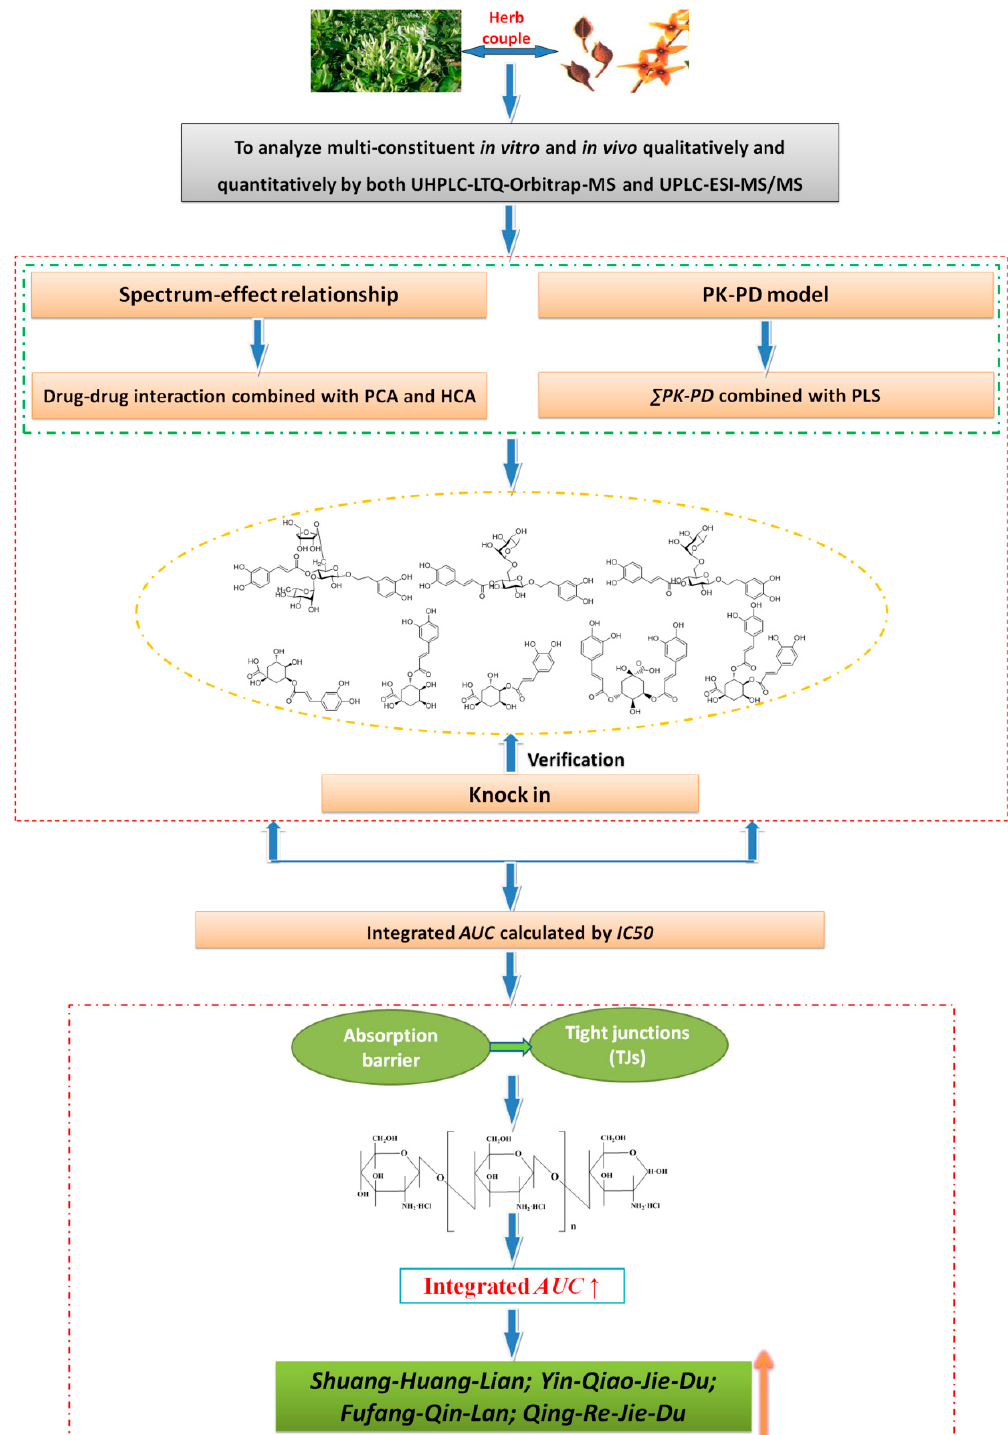
Figure 6. The evaluation system of bioavailability establishment and related pharmaceutical technology applications for the Flos Lonicerae Japonicae - Fructus Forsythiae (FLJ-FF) herb couple ( ↑ : improvement).